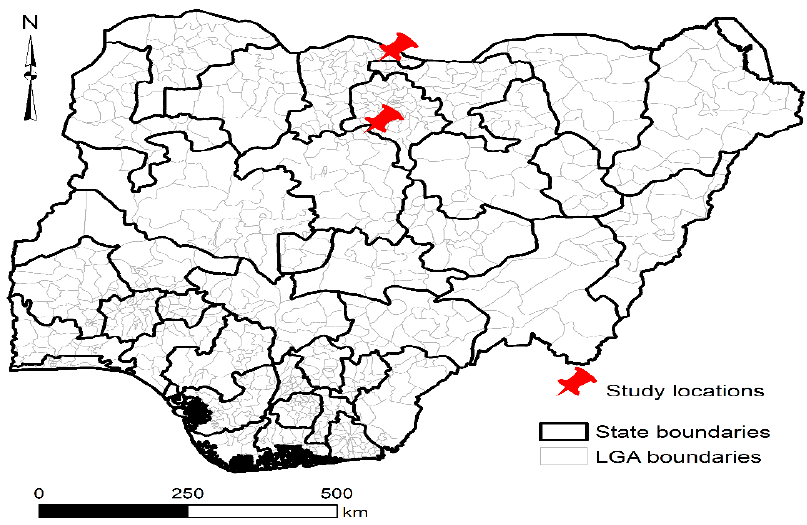
Figure 1. Map of Nigeria showing the two study communities, Zango (Katsina State) and Kofa (Kano State). Zango is situated at latitude 13°03 ′ 19.0 ″ North and longitude 8°29 ′ 17.2 ″ East while Kofa lies on latitude 9°41 ′ 14.6 ″ North and longitude 7°41 ′ 12.4 ″ East.